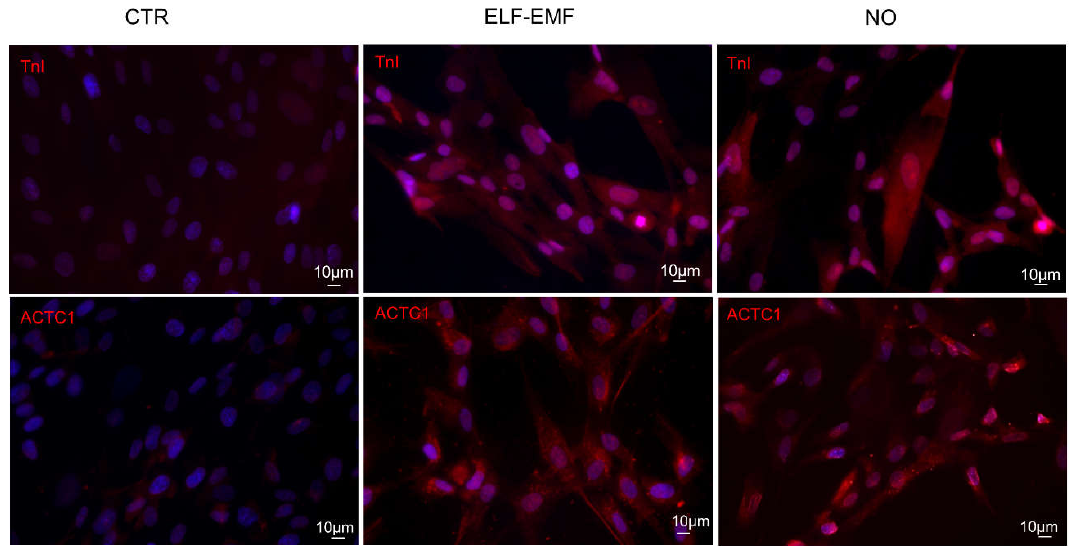
Figure 5. hAMSC protein expression by indirect immunofluorescence analysis of TnI, and ACTC1 (red): control cells (CTR), 5 days 7 Hz, 2.5 μT exposed cells (ELF‐EMF) and cells treated with 0.4 mM of Nitric Oxide (NO). Nuclei are counterstained with Hoechst (blue) ( n = 3).